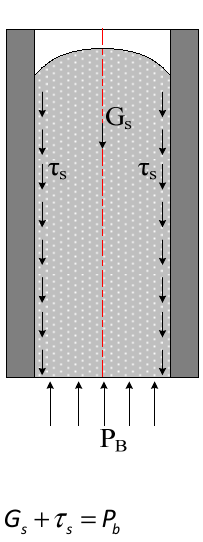
Figure 13. Sketch map of forces on the